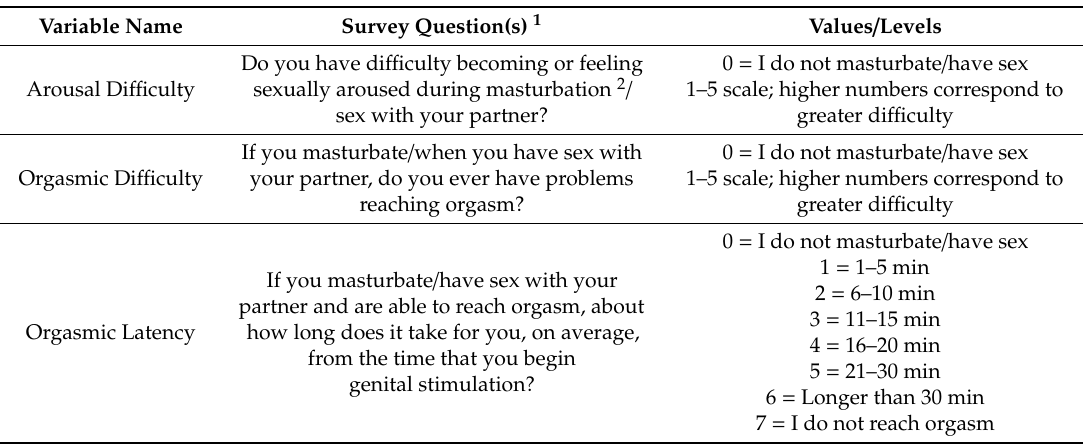
Table A2. Survey questions for the outcome